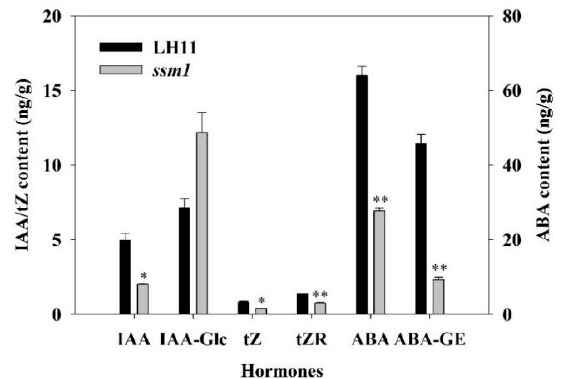
Figure 3. Hormone content in seeds of ssm1 and LH11 at DAP20. IAA: Indole-3-acetic acid; IAA-Glc: 1-O-indol-3-ylacetylglucose; tZ: trans-Zeatin; tZR: trans-Zeatin Riboside; ABA: Abscisic acid; ABA-GE: ABA-glucosylester. Three biological replicates were used for statistical analysis ( t -test; * p < 0.05, ** p < 0.01). Values represent means ± SE ( n = 3).